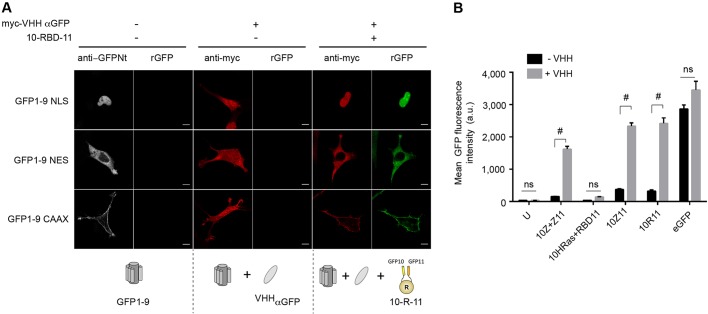
An anti-GFP nanobody binds to the rGFP and boosts split-GFP fluorescence. (A) Left panels, representative images of GFP1-9 localization (anti-GFPNt antibody staining, gray) for GFP1-9 variants targeted to the nucleus (NLS), cytoplasm (NES) and the plasma membrane (CAAX). Localization of the anti-GFP VHH nanobody (anti-Myc staining, red) with GFP1-9 variants alone (middle panels), and in the presence of a self-assembling GFP10–RBD–GFP11 (10-R-11) domain that induces split-GFP complementation (right panels). Scale bars: 10 μm. (B) Quantification of split-GFP fluorescence intensity of MRC5-SV_GFP1-9 cells expressing (+) or not (−) the VHH domain and transfected with the indicated constructs: interacting leucine zippers (10Z+Z11), non-interacting 10HRas and RBD11, and GFP1-9 self-associating domains [GFP10–Zipper–GFP11 (10-Z-11) and GFP10–RBD–GFP11 (10-R-11)]. U, untransfected cells. Mean fluorescence intensity was quantified in GFP10+GFP11+ expressing cells after double immunostaining with anti-GFP10 and anti-GFP11 antibodies; full-length eGFP fluorescence was collected in the whole cell population. Results are mean±s.e.m.; n=3 independent experiments. #P<0.0001; ns, not significant (multiple t-tests using the Holm–Sidak method with α=5%).